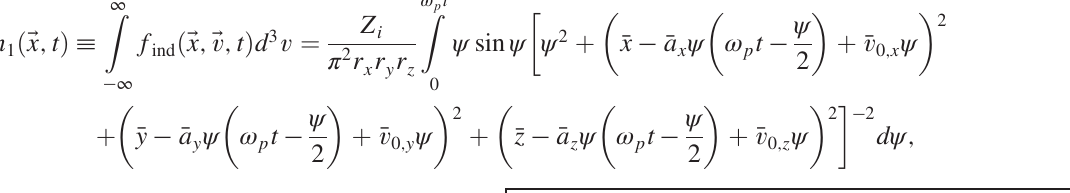
: 0 (red), 0.5 z , z Þ . The snapshot is taken at = ð r r r and y ¼ 0 . 1 r in units of Z x y i x y z ¼ β ;z v;z